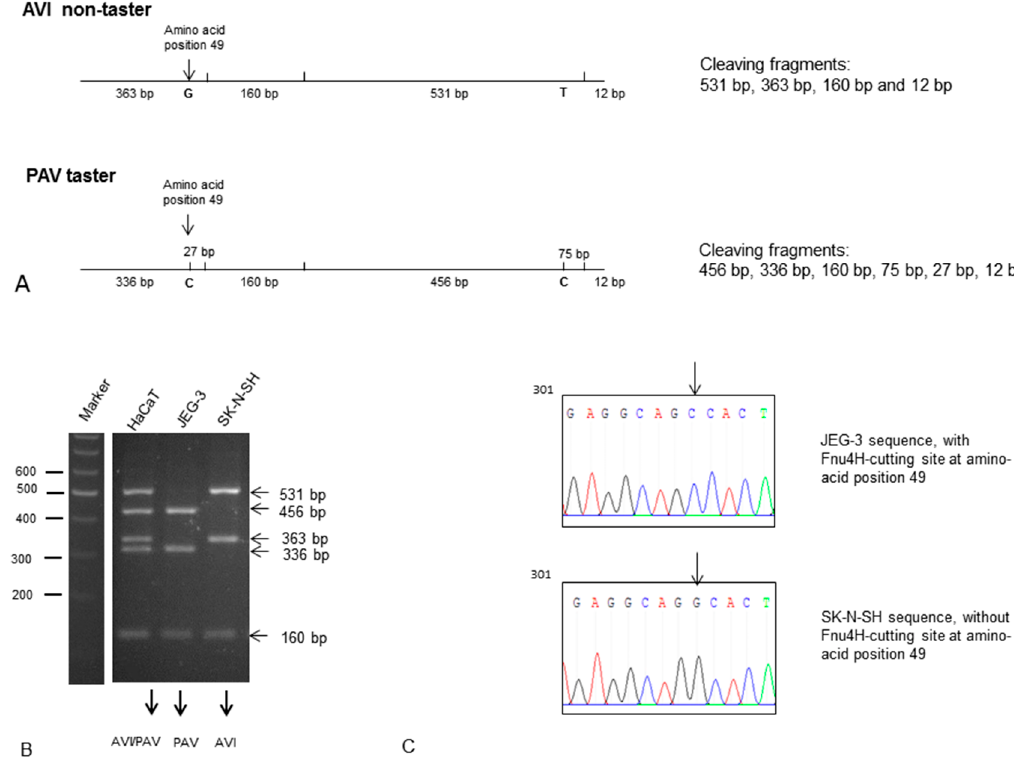
Figure 5. Determination of the TAS2R38 gene allele in the cell line JEG-3. ( A ) Scheme to demonstrate the cleaving products by a restriction enzyme-based analysis of PTC taster and non-taster. PTC tasters have the haplotype PAV and non-tasters have the haplotype AVI (A = Ala, V = Val, I = Ile) at the protein positions 49, 262 and 296; ( B ) Cleaving pattern of the JEG-3 cell line. ( C ) Gene sequence of JEG-3 DNA. Both methods identified JEG-3 as taster cell line according to data from the literature [8].